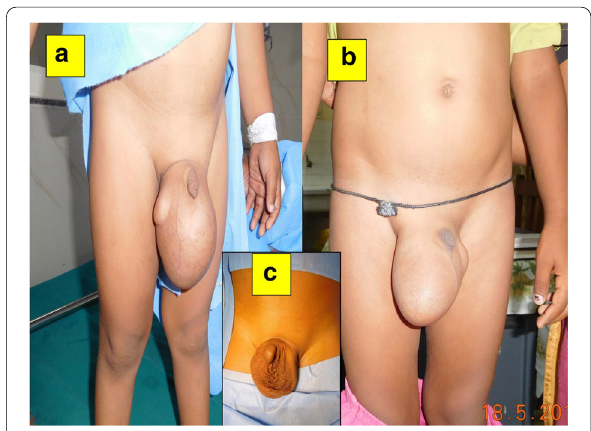
Fig. 1 a Clinical picture of Left giant inguinoscrotal hernia. b Clinical picture of Right giant inguinoscrotal hernia. c Reduction of hernial